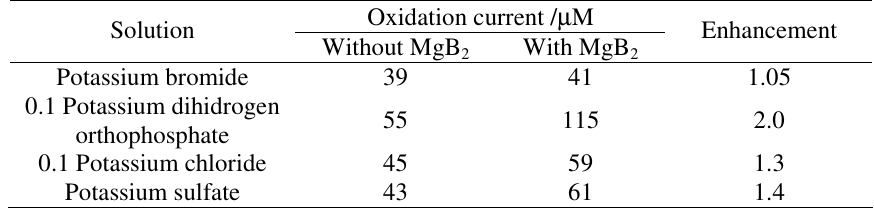
Table 1. Effect of varying supporting electrolytes of 1mM paracetamol, during cyclic voltammetry using at MgB /GCE with a scan rate of 100 mV/s 2